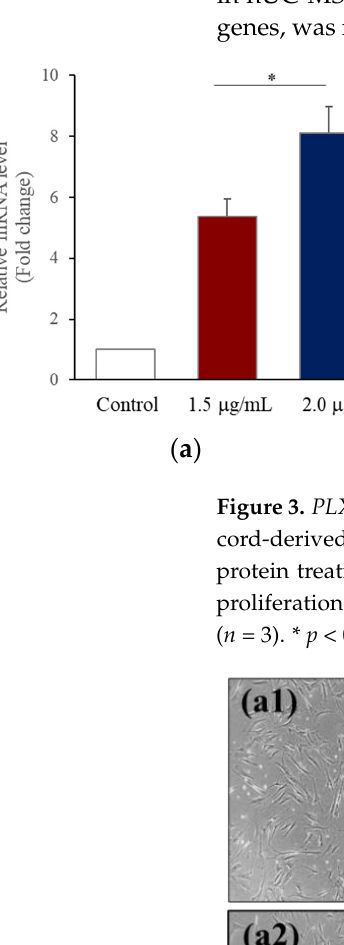
Figure 4. Morphological changes after recombinant PLXNA4 protein treatment for 5 days in human umbilical-cord-derived mesenchymal stem cells. ( a1 , a2 ): Untreated control cells. ( b1 , b2 ): 1.5 μ g of protein-treated cells. ( c1 , c2 ): 2.0 μ g of protein-treated cells. Original magnification 40×.